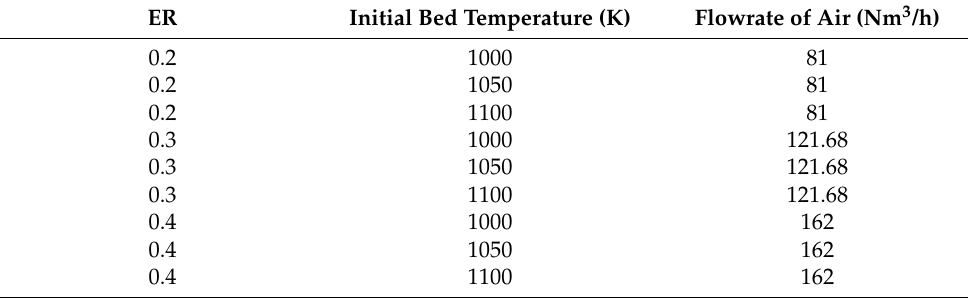
Table 4. The main simulation conditions.